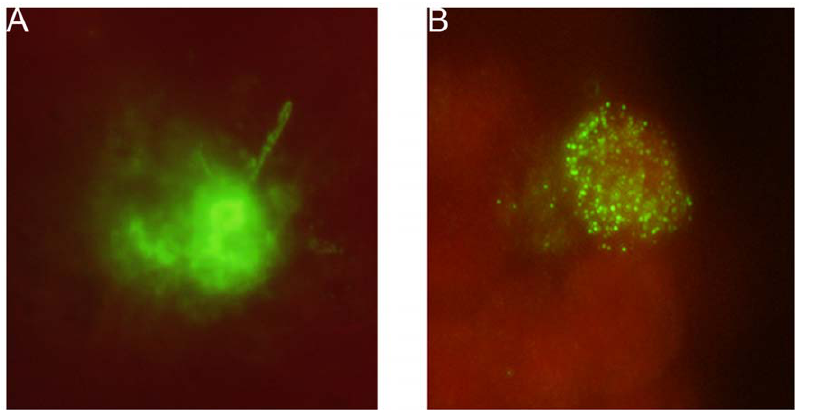
Figure 4. In-vitro development of late liver stage schizonts expressing PvMSP1. 20,000 HepG2-A16 cells were infected with 50,000 Pv spz. Three hrs later uninfected Pv spz were washed off and the culture was maintained for 9 days with daily media changes. Mature Pv liver stage schizonts (400 X magnification) in HepG2-A16 cells were stained with (A) the mAb to the PvCSP, NVS3 (20 m g/ml) or (B) with a mAb against Pv merozoite surface protein 1(PvMSP1), 3F8.A2 (1:50 dilution). As a negative control, uninfected HepG2-A16 cells were incubated with the individual mAbs and labeled secondary antibodies. There was no evidence of staining in these negative control cultures (data not shown).